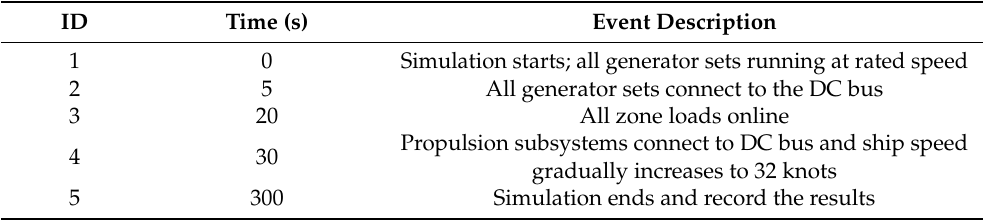
Table 3. Discrete event sequences during startup.